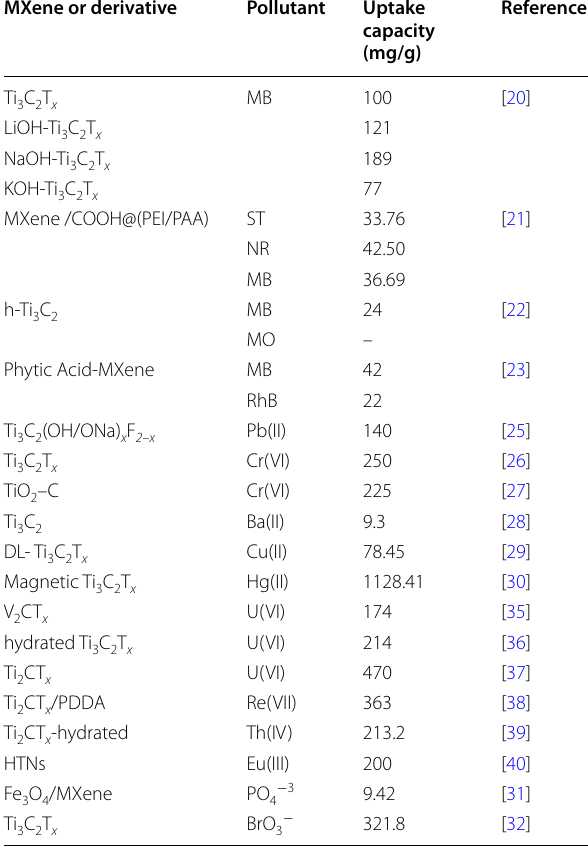
Table 1 Summary of specific uptake capacities of MXenes and MXene-based composites for dyes and